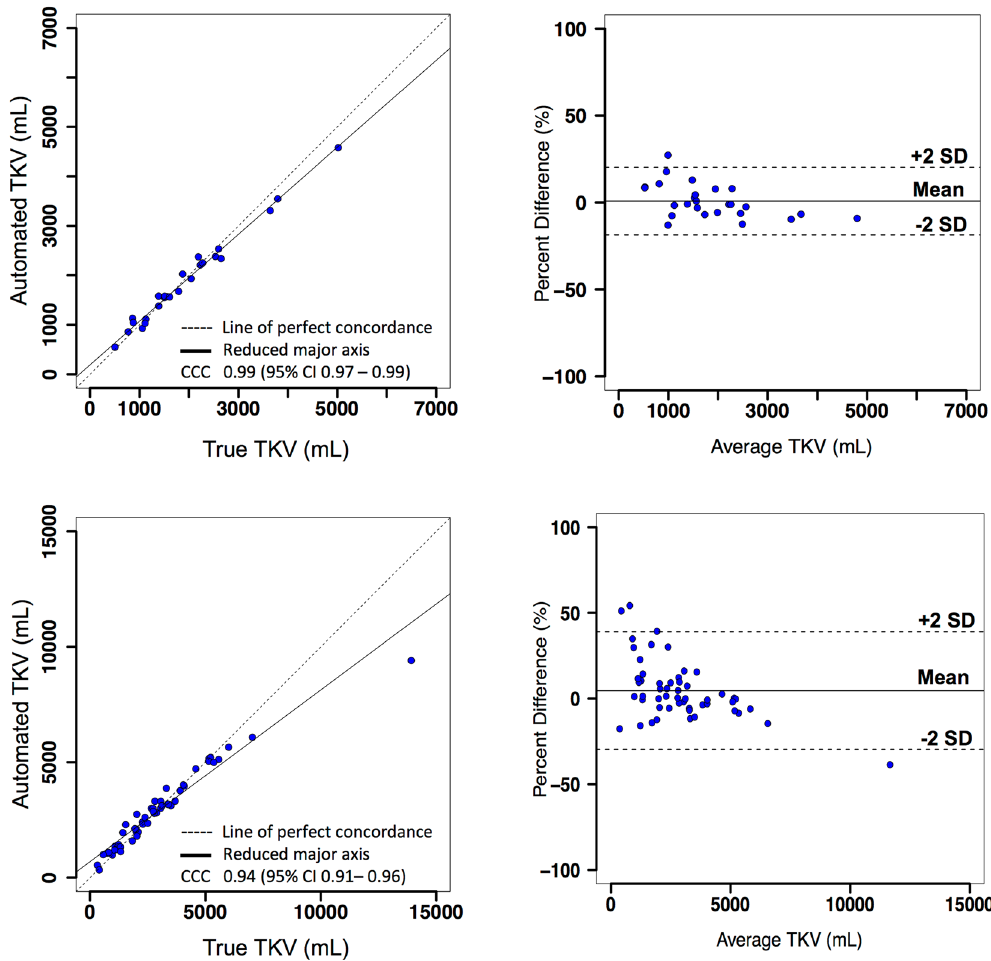
Figure 3. Left: Concordance Correlation Coefficient (CCC) plots showing strength of association; Right: Bland-Altman plots showing agreement between TKV measurements. TKV measurements from automated segmentation method (main experiment) are compared with true TKV measurements from manual segmentations for study 1 (top, n = 26) and, studies 2 and 3 (bottom, n =